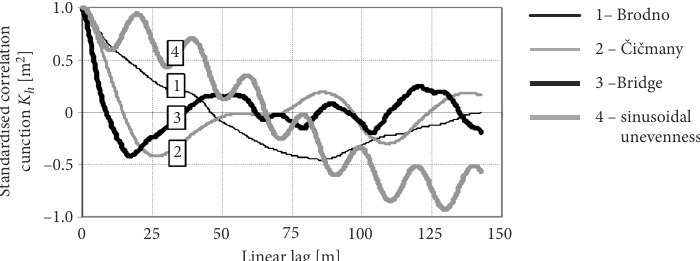
Figure 8. Standardized correlation function of stochastic unevenness of selected road sections and harmonic curve